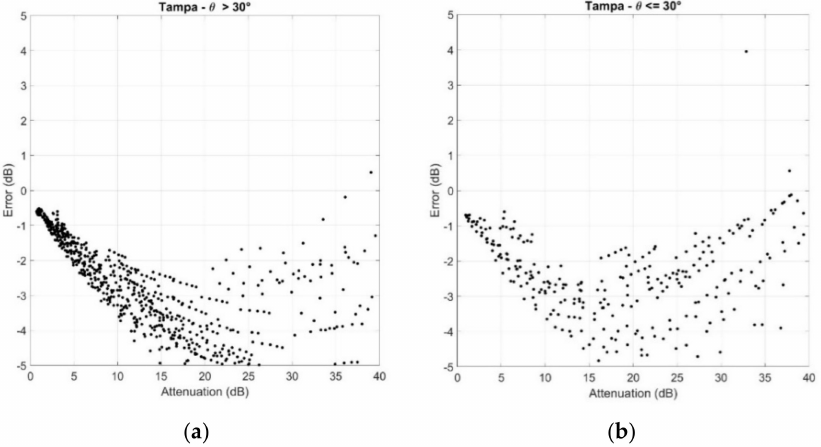
Figure A5. Scatter plots of the error ε = A SST , glo − A SST versus A SST : ( a ) θ > 30 ◦ ; ( b ) θ ≤ 30 ◦ . Tampa.